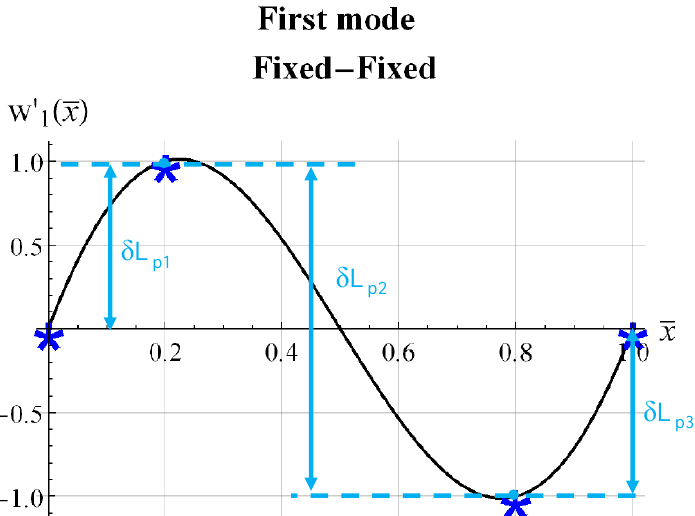
Figure 10. Virtual works of the piezoelectric forces ( δ L p ) in the case of the first eigenmode excitation in a fixed-fixed beam. The FEM results highlight the optimal location of the voltage sign switch (illustrated with blue